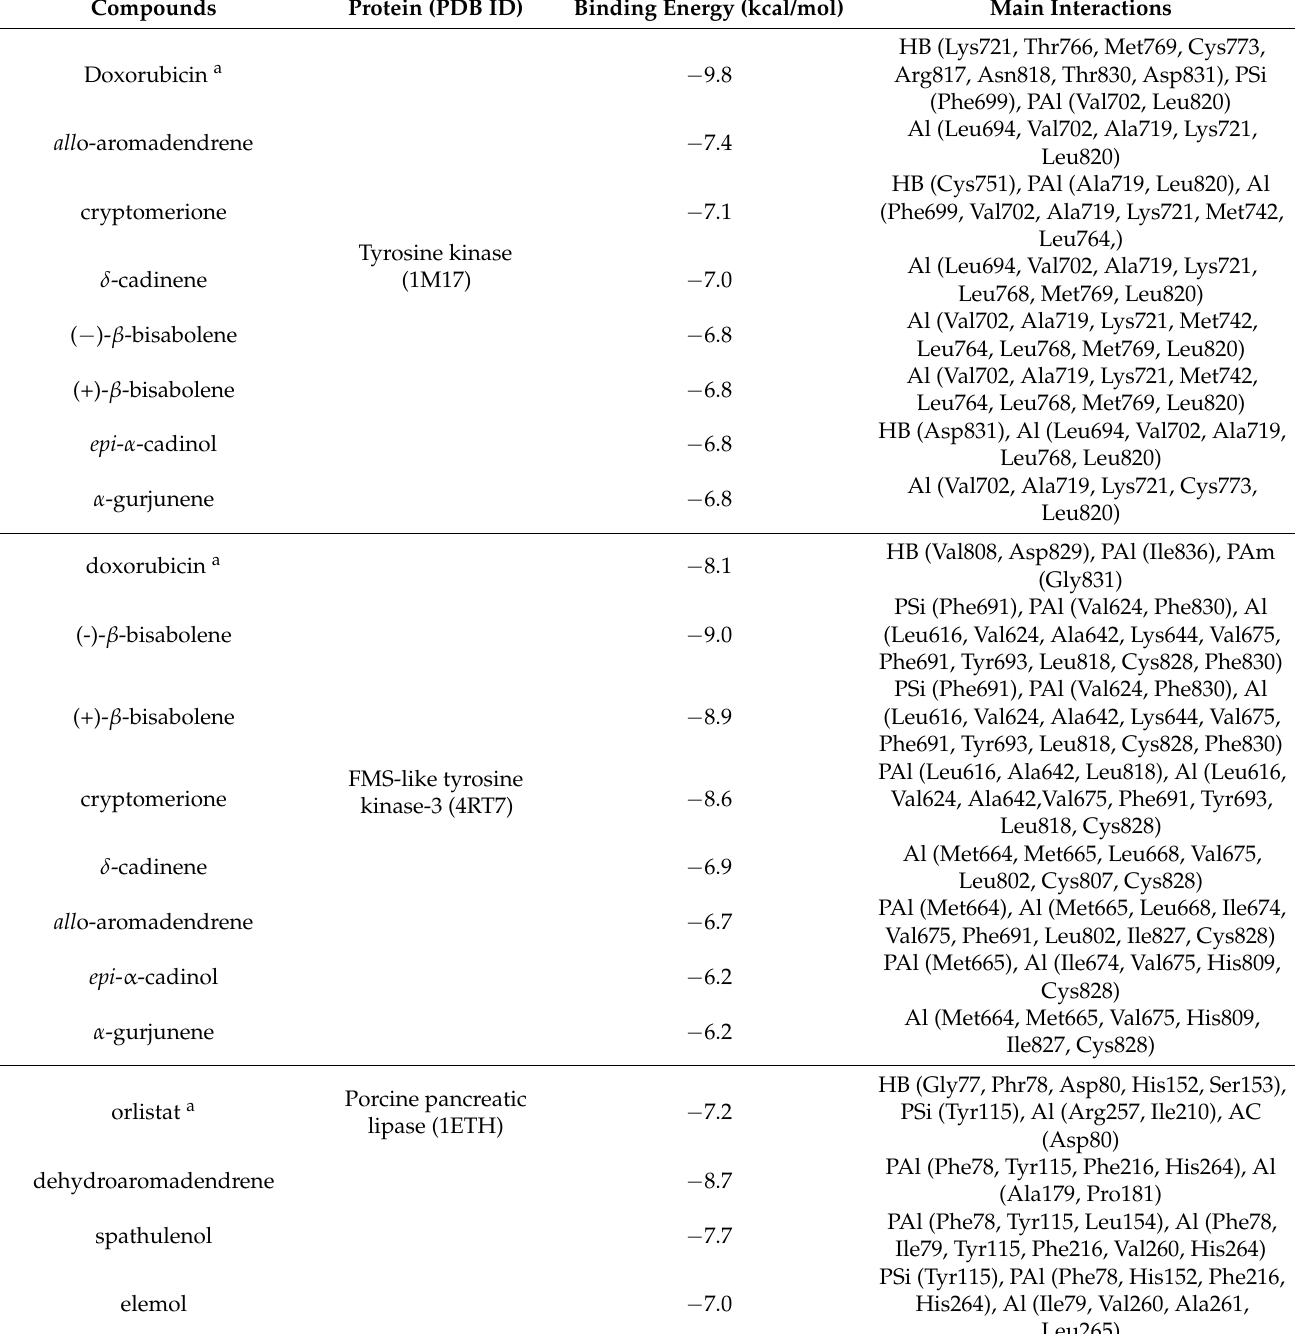
Table 4. Docking results for the main constituents of the active essential